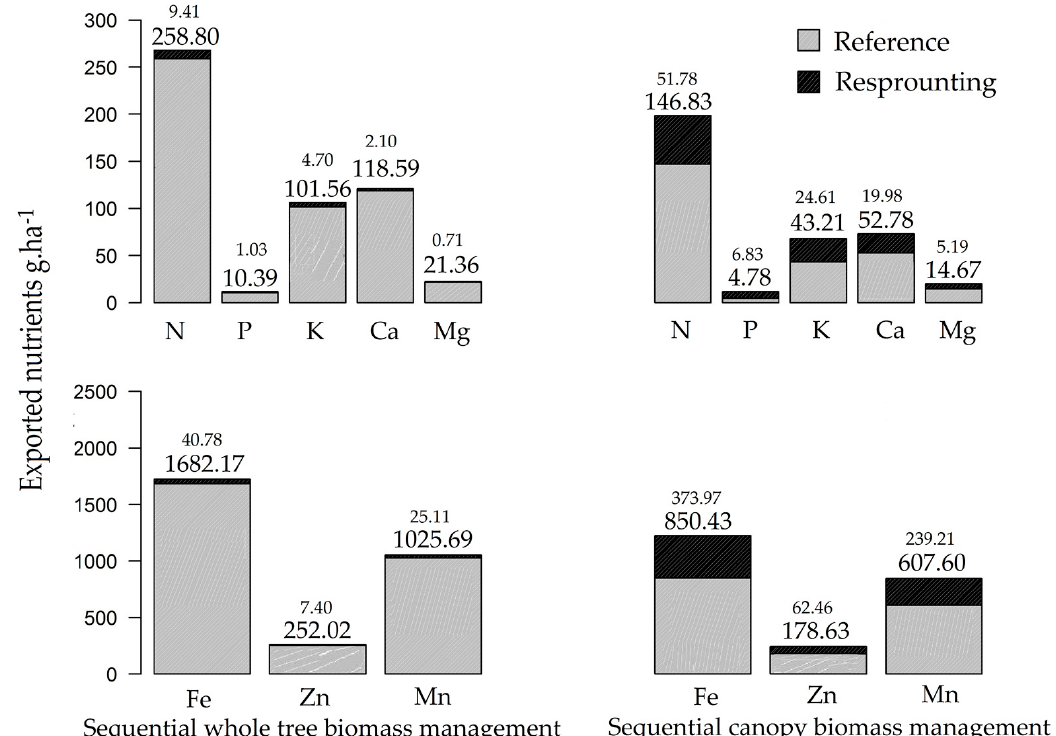
Figure 6. Quantities of macro and micronutrients exported by sequential management of above ground dry mass of Central Amazonian rosewood. Larger sized numbers correspond to the first harvest, and smaller sized numbers to the second harvest.